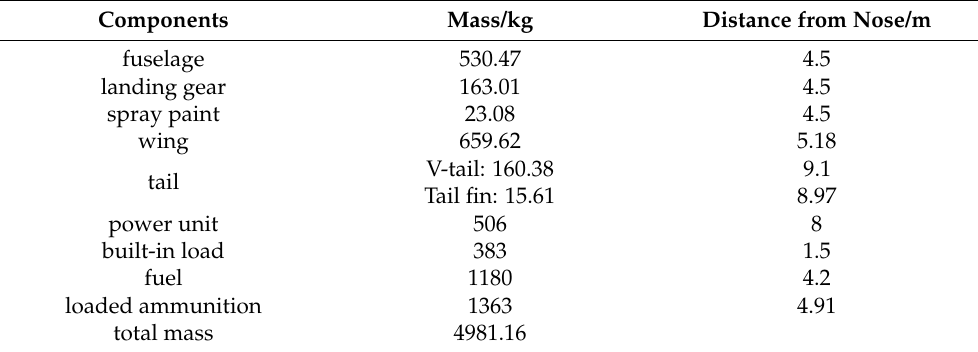
Table 2. Mass and centroid position of major components of targeted morphing